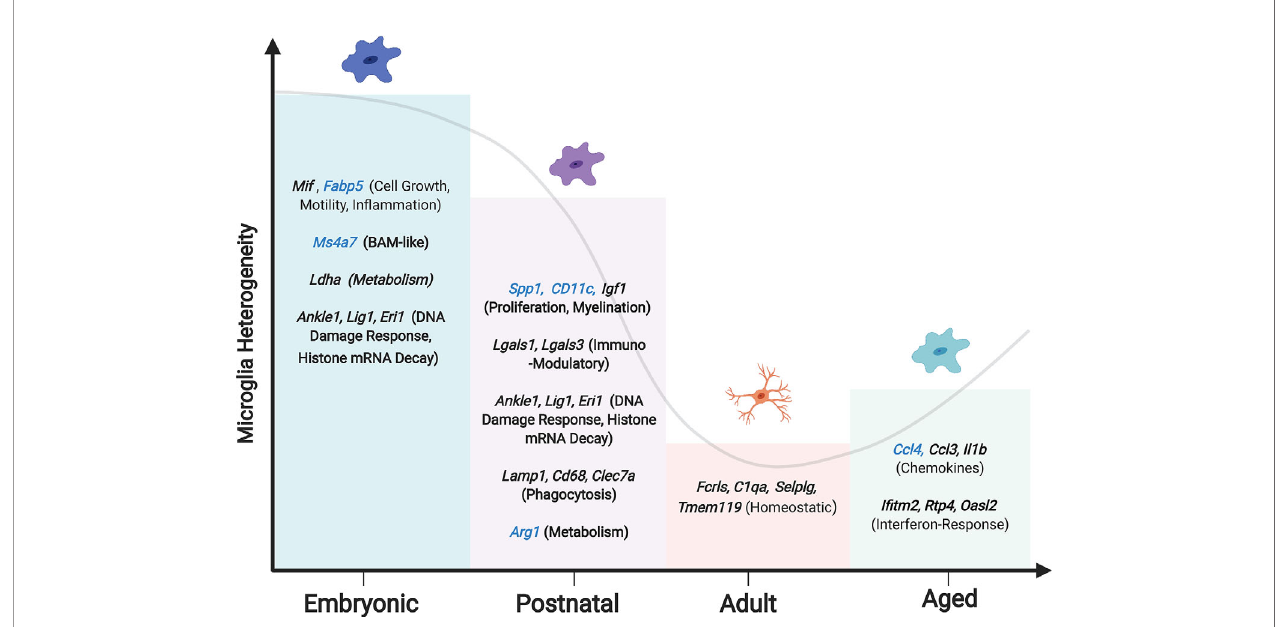
FIGURE 2 | Changing microglia heterogeneity throughout development. Peak microglial heterogeneity is seen during embryonic development, with a decrease in adulthood, and a subsequent increase in the aged brain (65). Enriched genes and phenotypes signi fi cant to each microglial developmental stage are shown, with genes that are unique to each stage in blue. Hammond et al. reported a subset of embryonic microglia uniquely expressing Ms4a7 , suggesting a similarity to